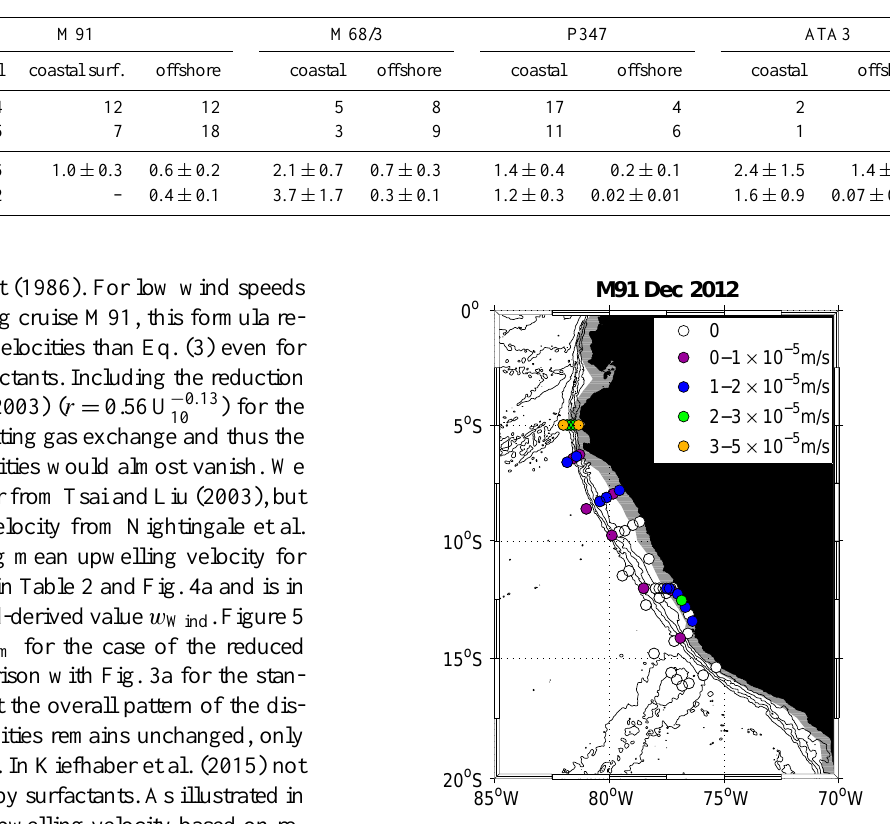
Figure 5. Helium-derived vertical velocity for cruise M91. As in Fig. 3a, but applying a reduced gas transfer velocity in the coastal area due to the presence of surface